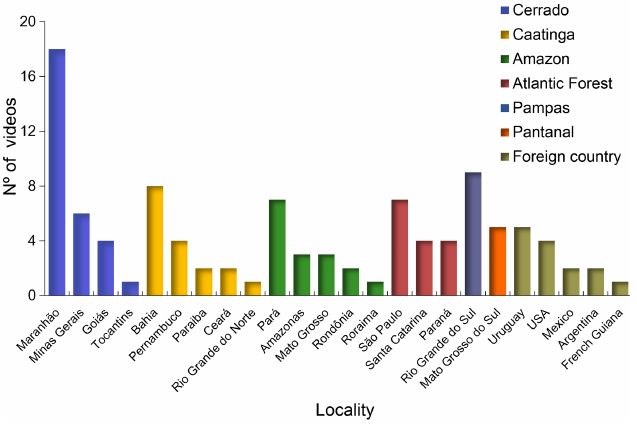
Fig. 5 . Distribution of the number of Brazilian sport hunting videos found by Brazilian state and biome or foreign